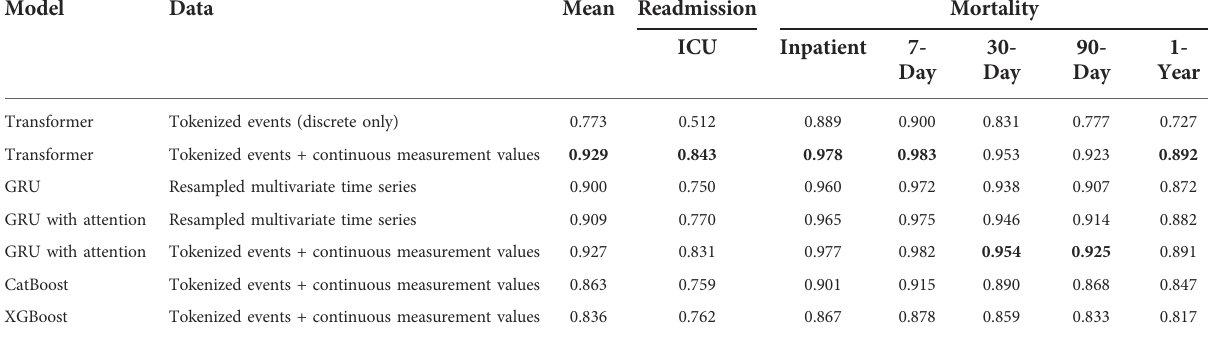
TABLE 3 Multi-task prediction results expressed as area under the receiver operating characteristic curve (AUROC).